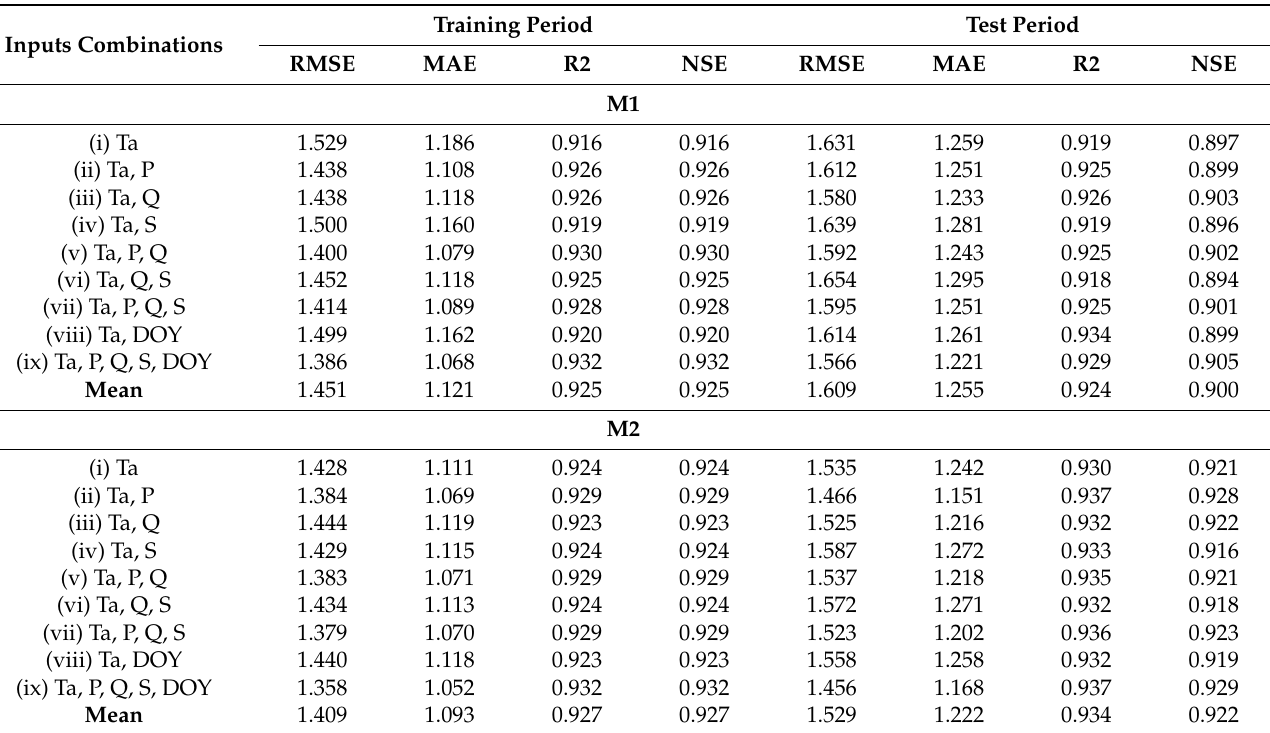
Table 7. Training and test statistics of the models for water temperature